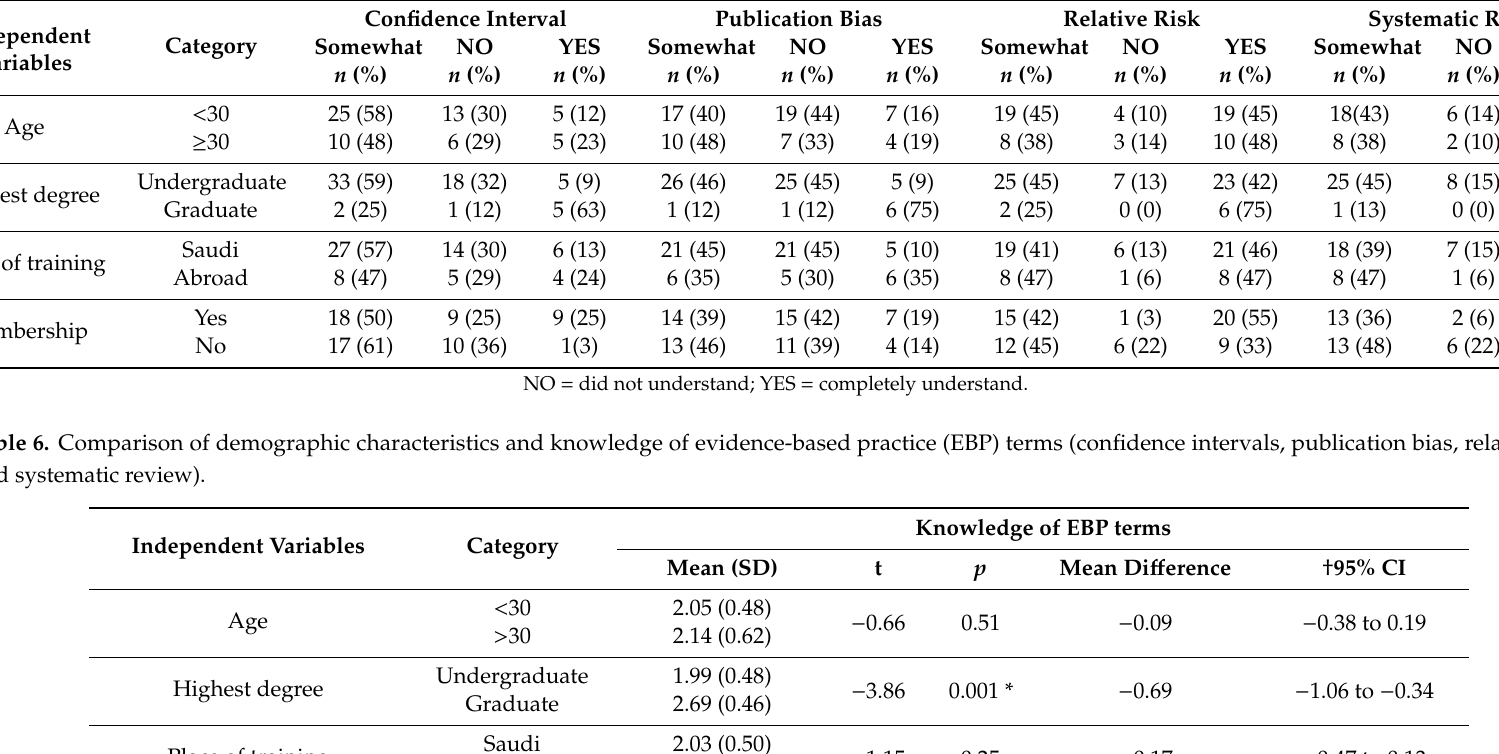
Table 5. Proportions of therapists’ self-reported knowledge of evidence-based practice (EBP) terms (confidence intervals, publication bias, relative risk, and systematic review).